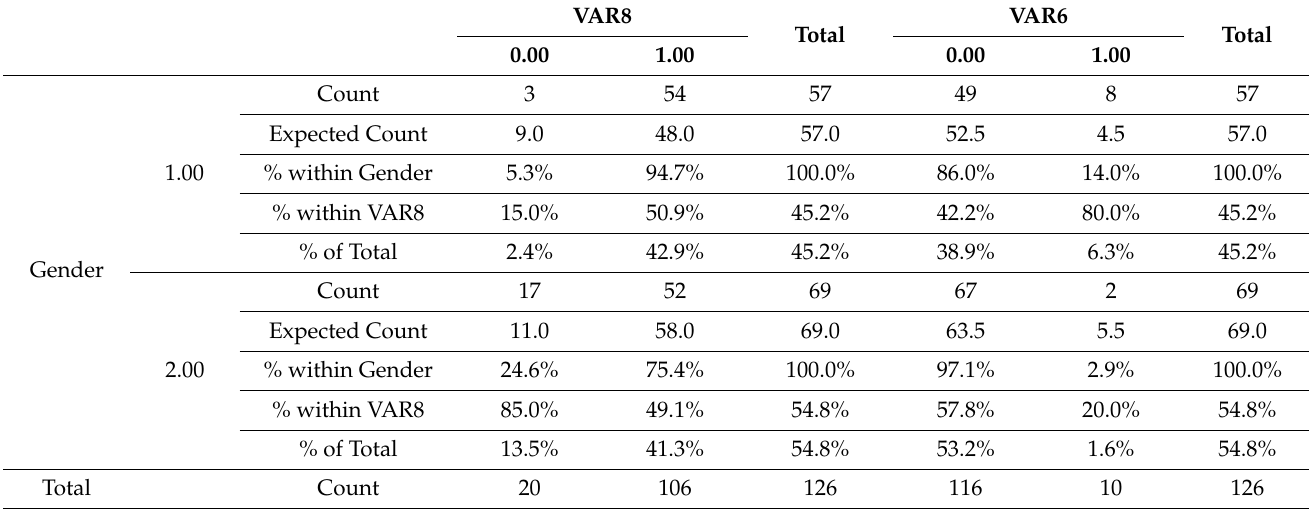
Table 8. The difference between female and male individuals against variables 8 and